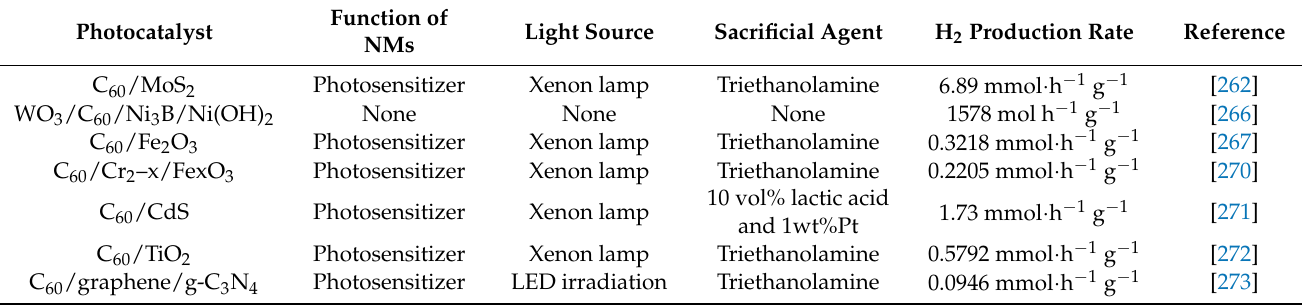
Table 6. Fullerene-based materials and H 2 production